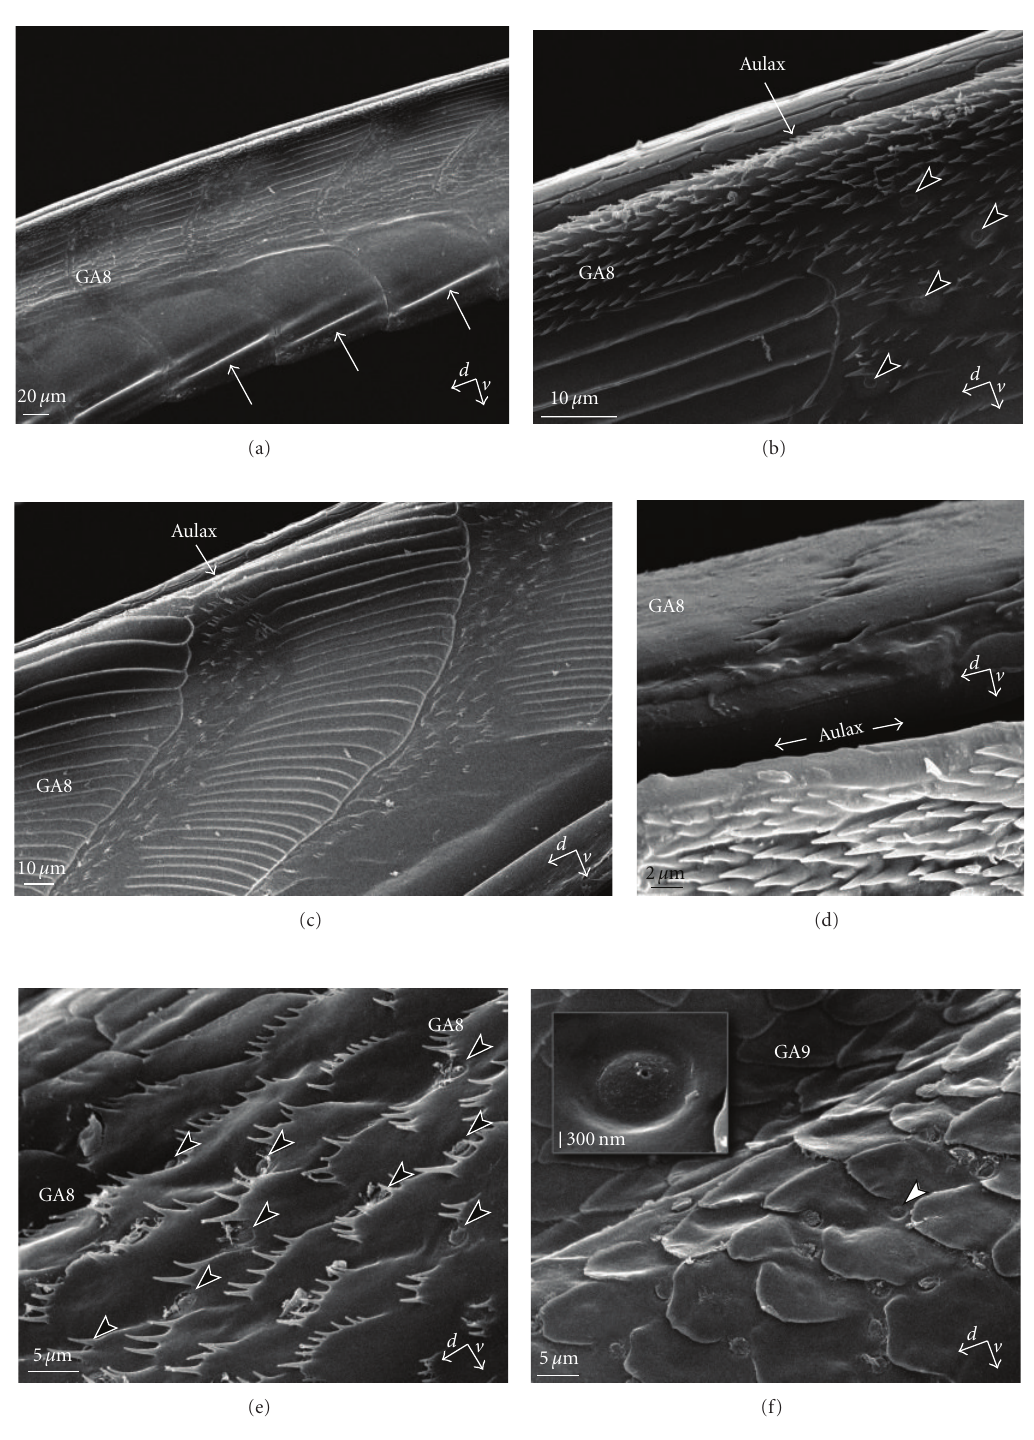
Figure 2: SEM micrographs of the inside surface of the gonapophyses in Tricholepidion gertschi : (a) middle part of the 8th gonapophysis; (b) dorsal margin of the 8th gonapophysis showing microtrichia, sensilla, and longitudinal ridges; (c) one transverse sculptured field of the 8th gonapophysis; (d) aulax; (e) basal part of the 8th gonapophysis with spine-bearing scales and sensilla; (f) basal part of the 9th gonapophysis with squamous microsculpture and sensilla (one sensillum is enlarged in inset). Arrowheads indicate uniform dome-shaped sensilla, externally identical to the campaniform sensilla with a central moulting pore on the ovipositor of the glassy-winged sharpshooter, Homalodisca coagulata [13, Figure 4]. Arrows indicate ventral corrugations of the 8th gonapophysis. GA8 and GA9: the gonapophyses of 8th and 9th segments, respectively. d and v : distal and ventral directions,